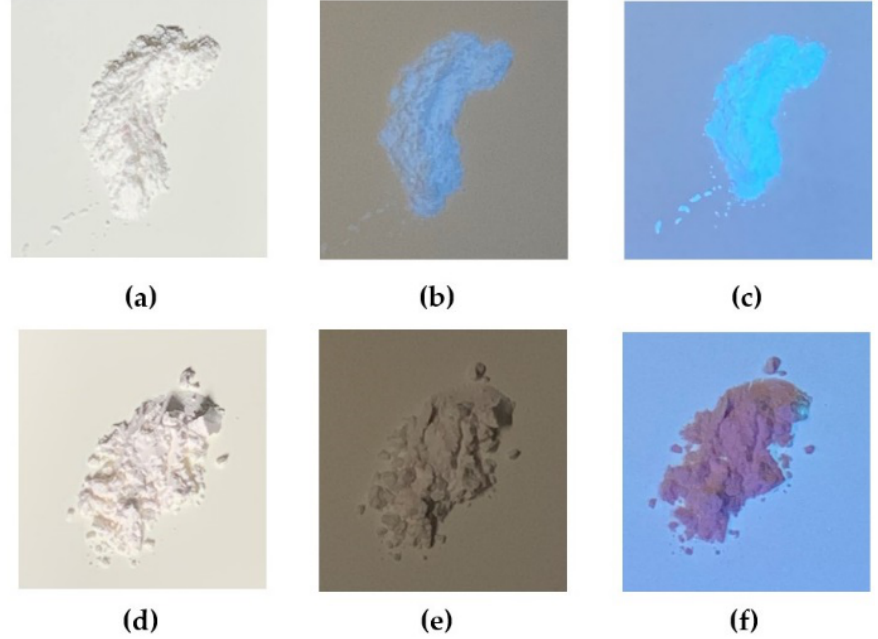
Figure 4. Photos of the PTSA-SiNPs prepared with PDADMAC as the intermediate ( a ) under sunlight, ( b ) 254 nm UV light and ( c ) 365 nm UV light; photos of the PTSA-SiNPs prepared without PDADMAC ( d ) under sunlight, ( e ) 254 nm UV light and ( f ) 365 nm UV light. Materials 2020 , 13 , x FOR PEER REVIEW